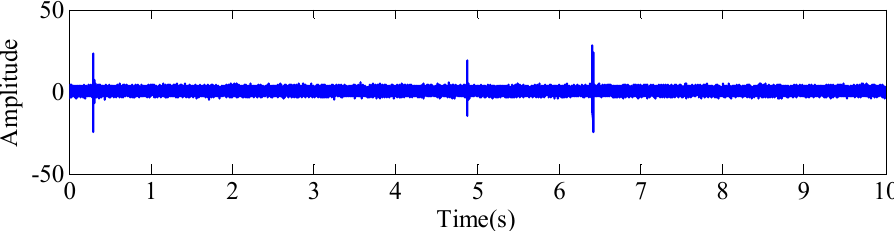
Figure 8. Singular value decomposition for noise reduction of Hankel matrix constructed by full signal.